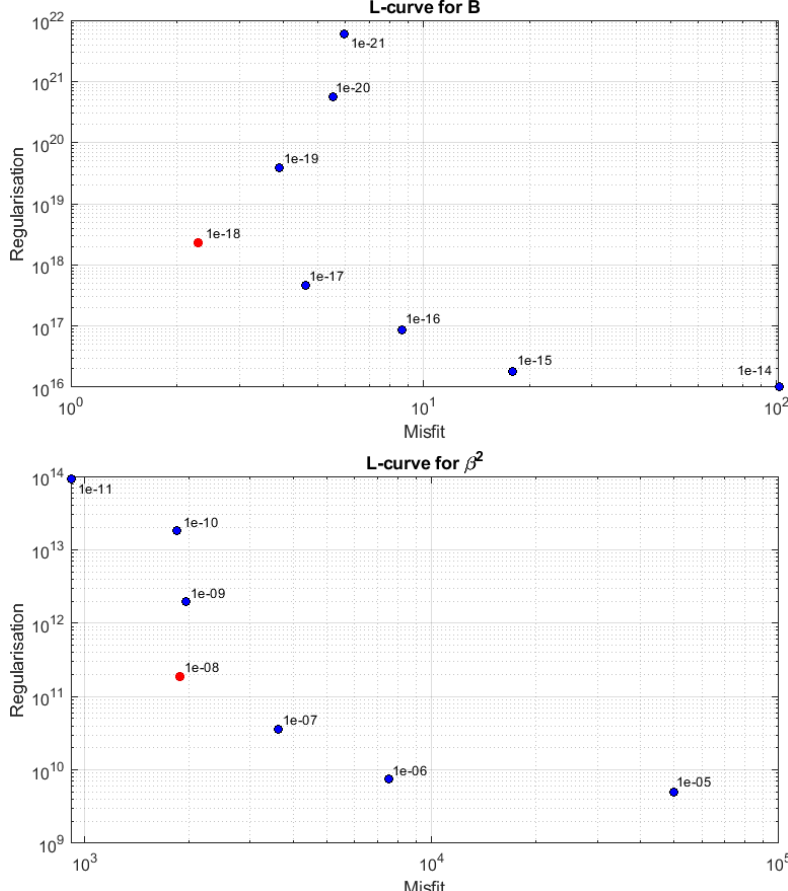
Figure A2. L -curves for ISSM. Points are labelled with values of α , and the chosen values are indicated in red.